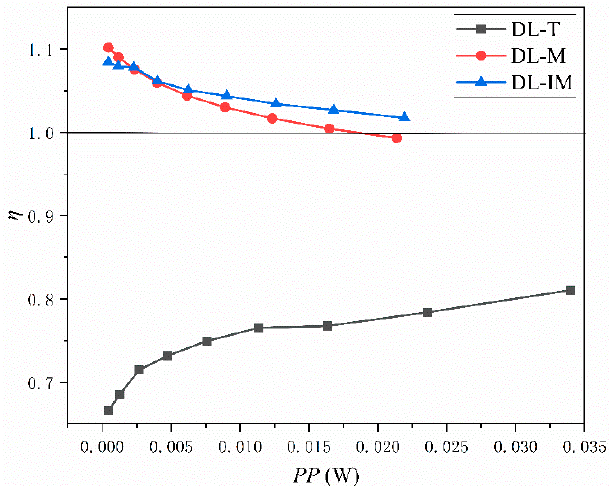
Figure 18. Thermal-enhanced factor vs. pumping power.